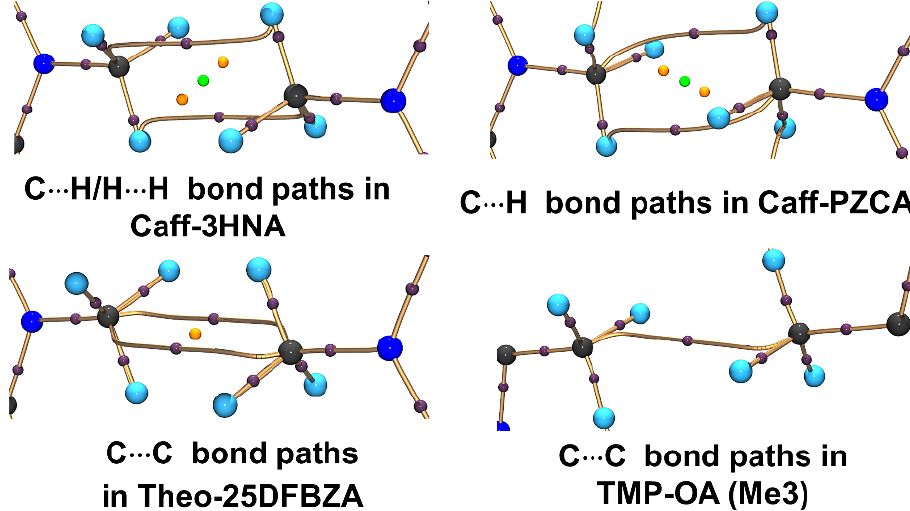
Figure 16. Bond paths (golden curved segments) along with critical points of hydrophobic Me ··· Me interactions derived from experimental CDMM. (3, − 1) BCPs, (3,+1) ring critical point (RCP), and (3,+3) cage critical points (CCP) are represented by the violet, orange, and green spheres. Reprinted with permission from reference. Ref. [78] Copyright 2019, American Chemical